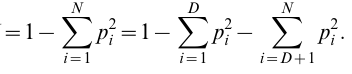
Table S2 The table is based on a large database of Y- chromosome data [2].There are 12727 haplotypes from 91 populations. Three different haplotypes are shown in followed by the most frequent haplotype occurring 661 times (5.2%). There are 2489 different haplotypes. The number of singletons is f1= 1397 while the number of rare haplotypes, i.e., those occurring at most 10 times, is 4649. From these numbers the coverage is estimated as 1 2 1397/4649= 0.7 with a 95% confidence interval ranging from 0.68 to 0.72.